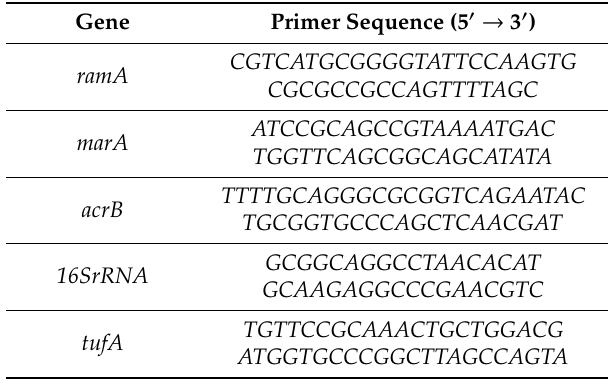
Table 1. The e ffl ux-pump-related genes and primer sequences used in RT-qPCR.